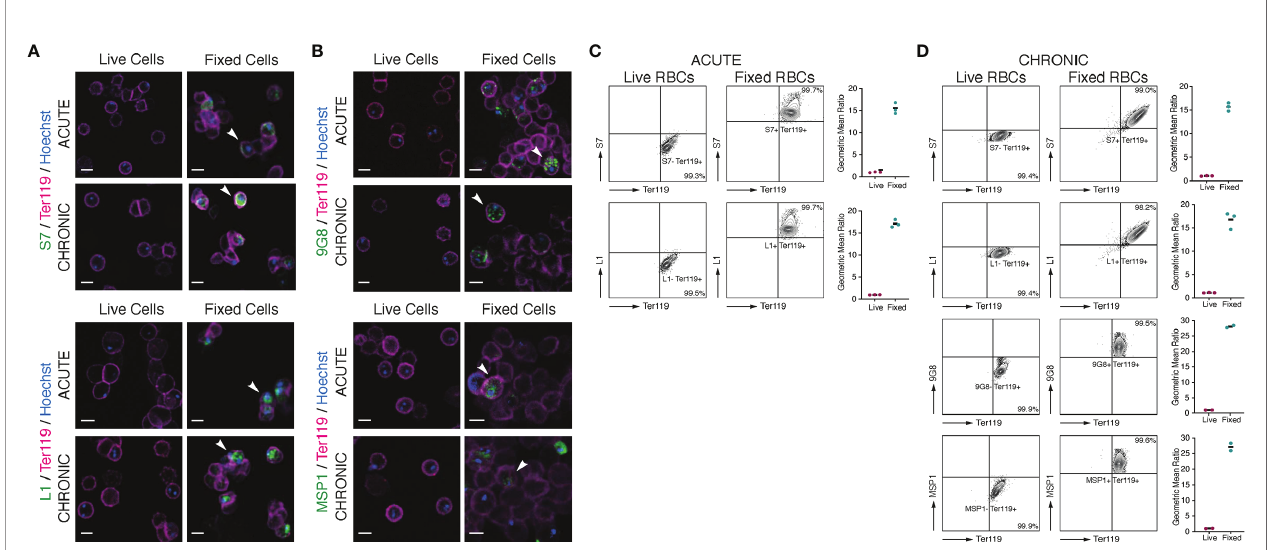
FIGURE 5 | Localisation of S7 and L1 PIRs in live acute and chronic MT P. c. chabaudi AS parasitised erythrocytes. (A, B) Immuno fl uorescence staining of live (left panels) and acetone:methanol- fi xed iRBC (right panels) of MT P. chabaudi parasites at the late trophozoite-stage, isolated from blood of C57Bl/6 RAG1 -/- mouse during acute (at day-7 post infection) (upper panels) and chronic (at day-45 post infection) (lower panels) infection. (A) P. chabaudi parasites were stained with either anti-S7 or anti-L1 peptide antisera (green). (B) 9G8 (upper panels) or anti-MSP1 (lower panels) monoclonal antibodies, which recognise parasite antigens internal to the iRBC or parasite, were used as negative controls for live imaging and positive controls for imaging the acetone:methanol fi xed iRBC. The RBC surface membrane was stained with anti-Ter119 antibody (magenta), and parasite nuclei were stained with Hoechst (blue). Staining with pre-immune rabbit serum was used as a negative control in the case of peptide antisera (data not shown). The white arrowheads in the panels with fi xed iRBC indicate L1, S7, 9G8 or MSP1 positive cells. Images were taken from confocal sections of live and acetone:methanol fi xed parasites at X630 magni fi cation and are representative of a total of 500-600 iRBC imaged across two individual replicates. Scale bar length corresponds to 5 m m. (C, D) Live P. chabaudi iRBC at the acute- (C) and chronic- (D) phases of infection in C57Bl/6 WT mice were labelled with the anti-S7 or anti-L1 peptide antisera, and anti-Ter119 monoclonal antibody, and analysed using the Amnis ® CellStream ® Cytometer. Representative contour plots (of 2-3 mice) show the percentage of the iRBC population (Hoechst+/Ter119+) that is either positive or negative for anti-S7 or anti-L1 peptide antisera binding. The quadrant gate was set based on the anti-S7 or anti-L1 background signal detected in the Hoechst- RBC for each condition. Acetone:methanol fi xed cells, which are also permeabilised, were used as a control to con fi rm antibody reactivity with P. chabaudi parasites. 9G8 or anti-MSP1 monoclonal antibodies were used as negative controls for live cells, and as a positive control for staining internal parasite proteins in fi xed/permeabilised cells. The side plots show the ratio of the geometric mean fl uorescence intensity (MFI) detected following binding of the anti-S7 or anti-L1 antibodies on Hoechst+ and Hoechst-, live and fi xed (control) RBC. Higher ratios indicate presence and higher abundance of the investigated proteins in Hoechst+ compared to the Hoechst- cells. Ratio of around 1 indicates no difference in the fl uorescence intensity of antibody binding (and therefore protein abundance) between the Hoechst+ and Hoechst- RBC. Three biological replicates (i.e., infected mice) were performed for antibody labelling of the S7 or L1 PIRs, whereas two replicates were conducted for antibody labelling with the 9G8 and anti-MSP1 monoclonal antibodies. Data for each individual mouse are presented in ( Supplementary Figure S5